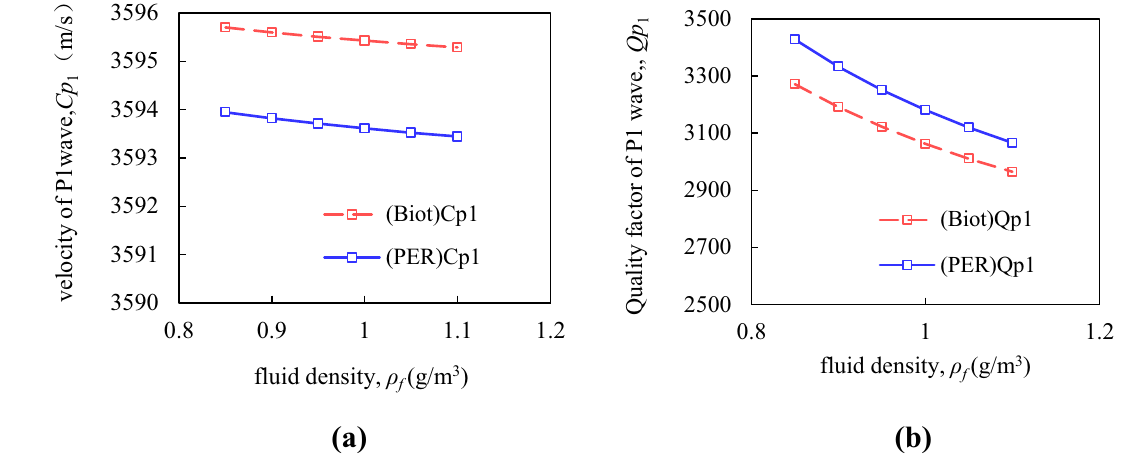
Fig. 5 Velocity and attenuation factor under different fluid density